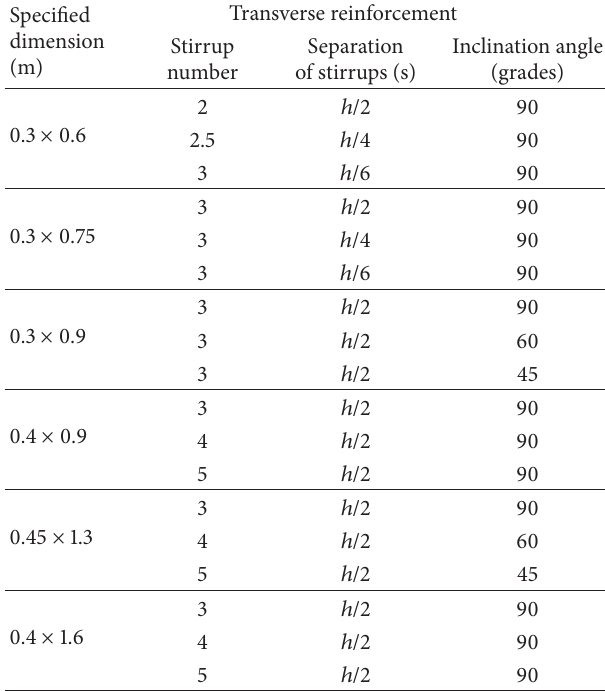
Table 4: Characteristics of transverse